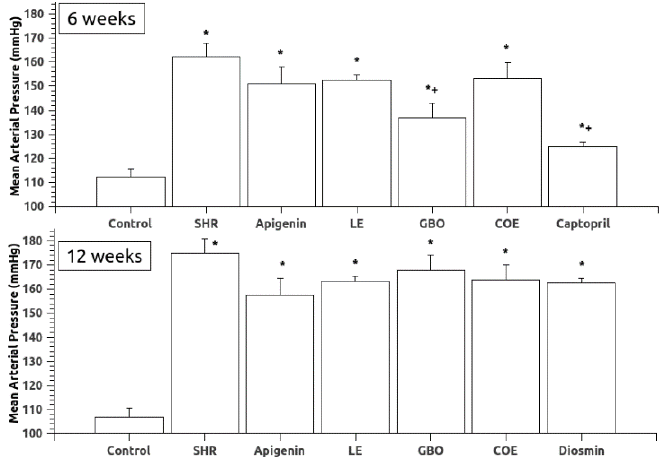
Figure 1. Mean arterial pressure (MAP) in the experimental groups. SHR (spontaneously hypertensive rats), LE (lemon extract), GBO (grapefruit + bitter orange extract), COE (cocoa extract). Data are mean ± S.E.M. * p < 0.05 vs. WKY; + p < 0.05 vs. SHR. Table 2. Final mean arterial pressure (MAP) and heart rate (HR) in the experimental groups.